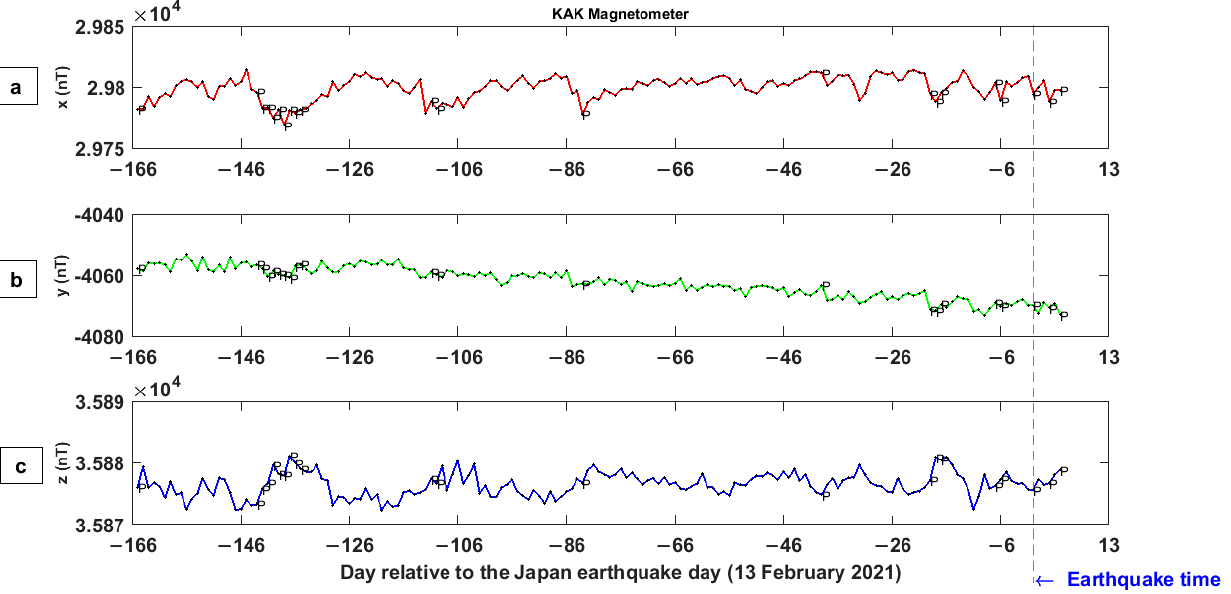
Figure 3. KAK magnetometer (36.232°N, 140.186°E) measurements ( a ) x, ( b ) y and ( c ) z during the period from 1 September 2020 to 18 February 2021. The dashed black vertical line indicates the earthquake day. The symbol “P” indicates a perturbed value by a geomagnetic storm.